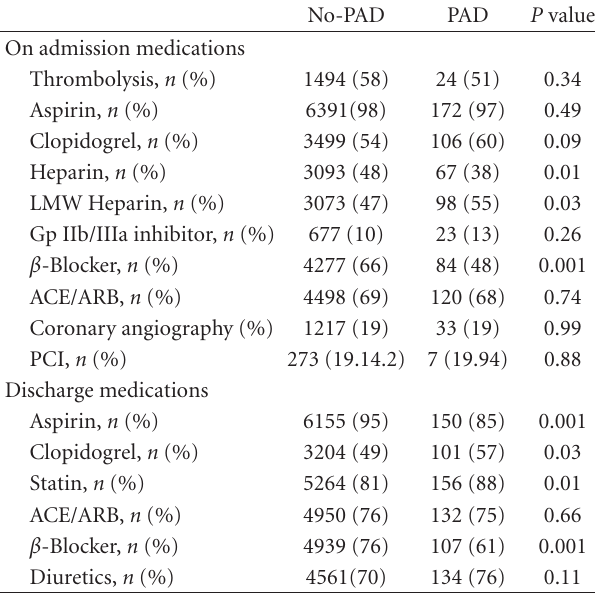
Table 2: Management of patients with acute coronary syndrome.